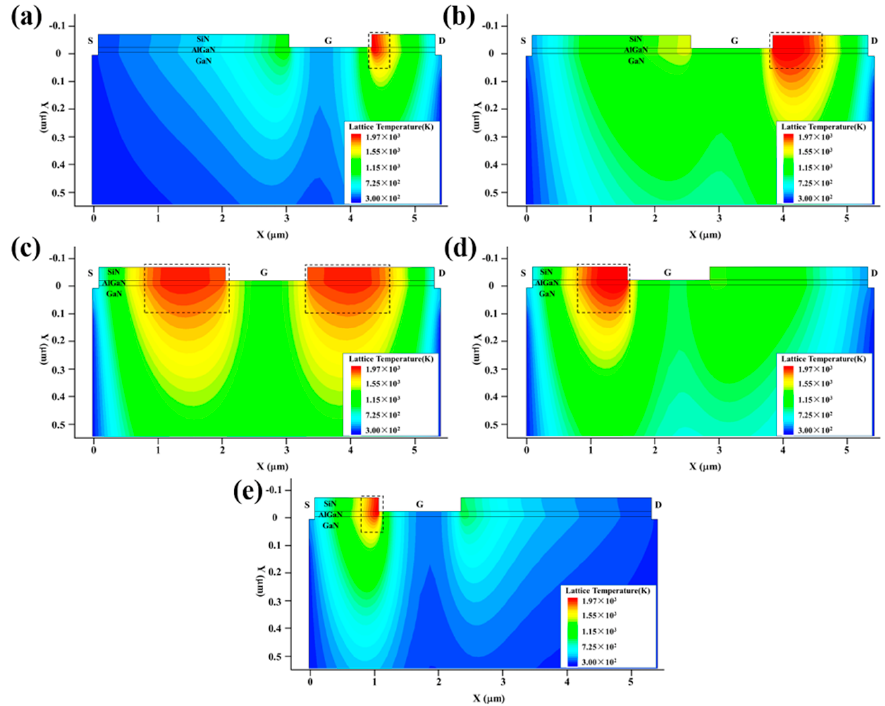
Figure 9. The thermal distribution of the GaN HEMT at the moment of burnout for different device structures: ( a ) Lgs:Lgd = 3:1; ( b ) Lgs:Lgd = 2.5:1.5; ( c ) Lgs:Lgd = 2:2; ( d ) Lgs:Lgd = 1.5:2.5; ( e ) Lgs:Lgd = 1:3.